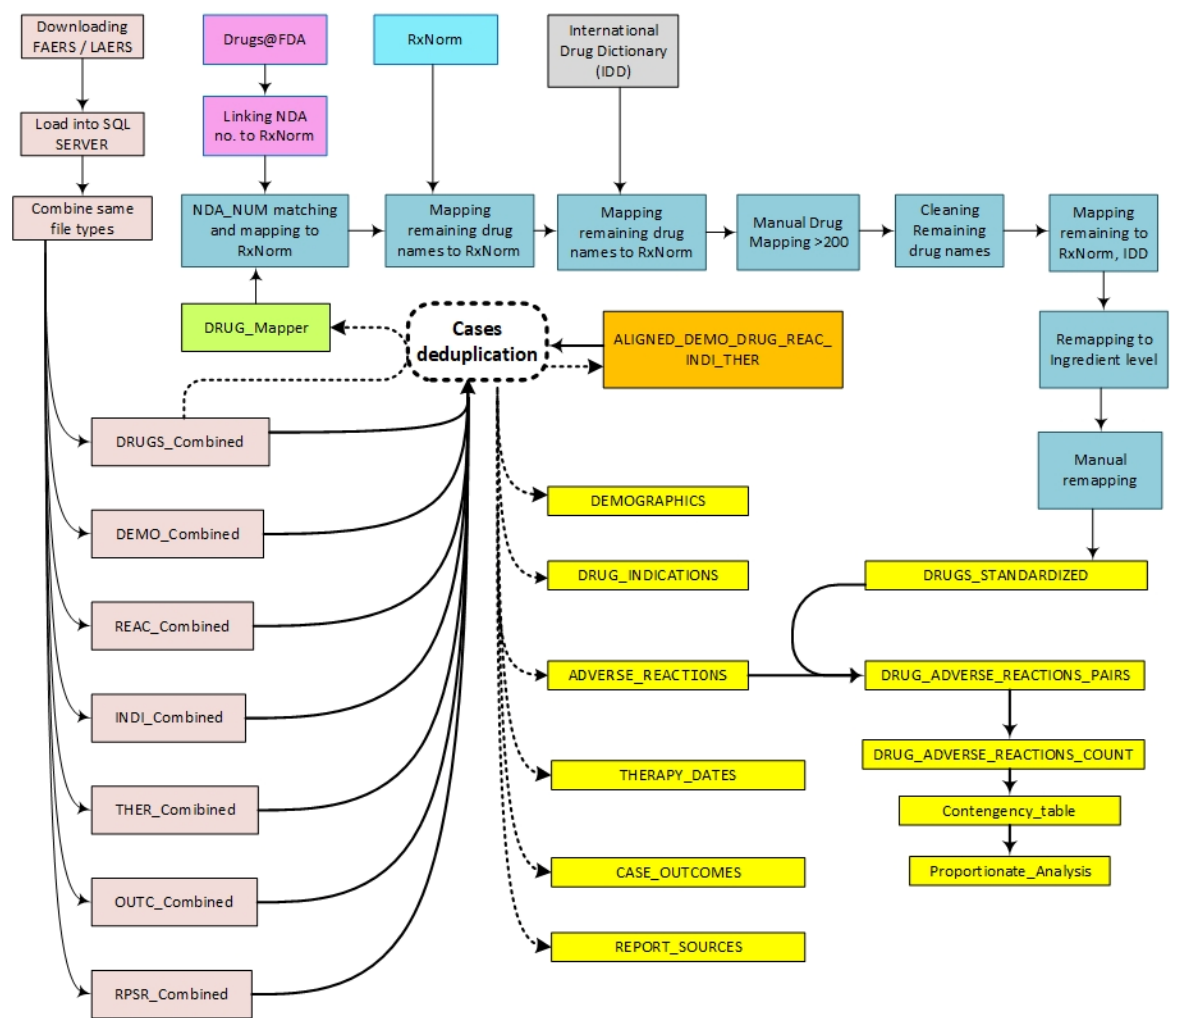
Figure 2. Steps of FAERS/LAERS dataset curation.